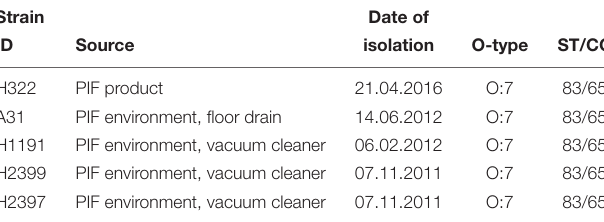
TABLE 1 | Details of C. sakazakii ST83 strains sequenced in this study.